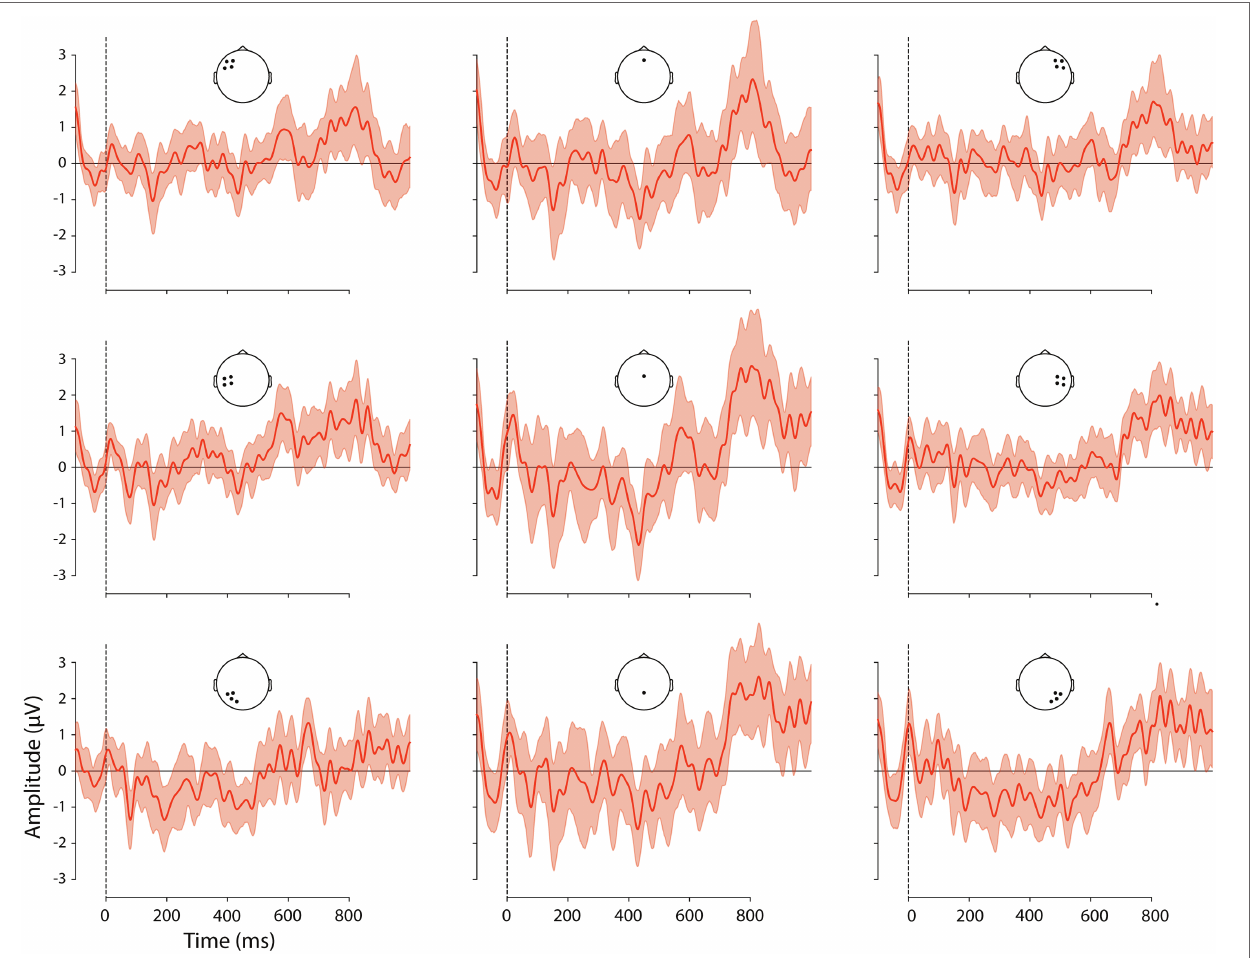
FIGURE 3 | Difference waveforms, the ERPs to V2 word order subtracted from that to V3 word order following idag ‘today’ at the nine ROIs. Confidence intervals (95%) are shaded. Positive plotted